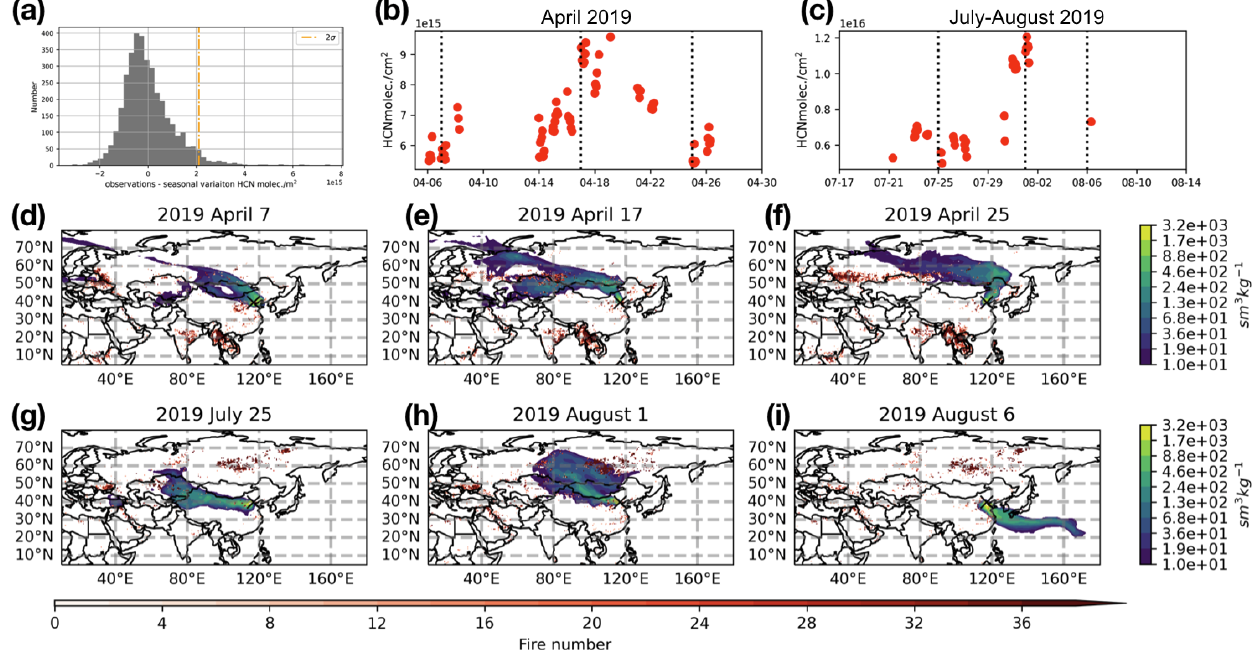
Figure 13. The frequency density of the FTIR HCN column variation (observations minus seasonal variation) (a) . The time series of the FTIR HCN total column measurements at Xianghe between 6 and 30 April 2019 (b) and between 17 July and 14 August 2019 (c) . For each period, 3d (approximately 1 week before the peak, the peak, and 1 week after the peak) are used to understand the air mass sources for each HCN enhancement period and shown as dashed black lines. The spatial distributions of the air mass response sensitivity in 10d backward simulations at Xianghe using the FLEXPART v10.4 model (similar to Fig. 10) on 7 April (d) , 17 April (e) , 25 April (f) , 25 July (h) , 1 August (i) , and 6 August 2019 (j)